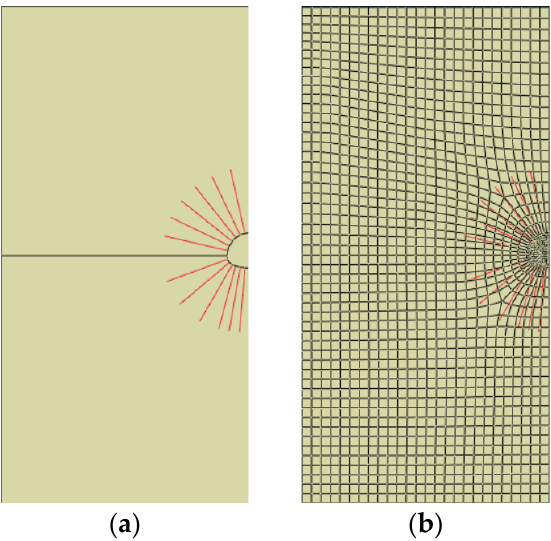
Figure 4. Numerical model: ( a ) cross–section calculation; ( b ) meshing diagram.